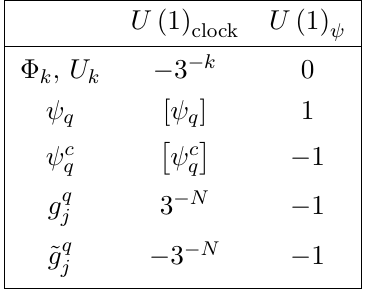
Table 1 . Charge assignment for spurion analysis. Notice that the brackets denote the charge under the U (1) , and not the charges under the U (1) clock as g u;d